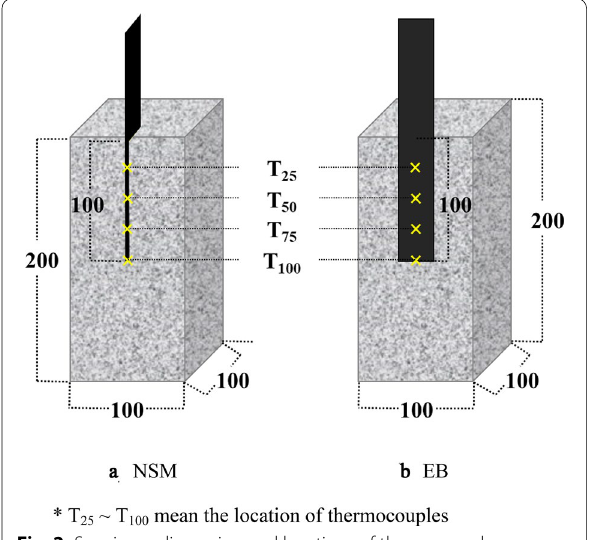
Fig. 2 Specimen dimension and locations of thermocouples. Fig. 3 Specimens after fire‑protection (NSM specimen).